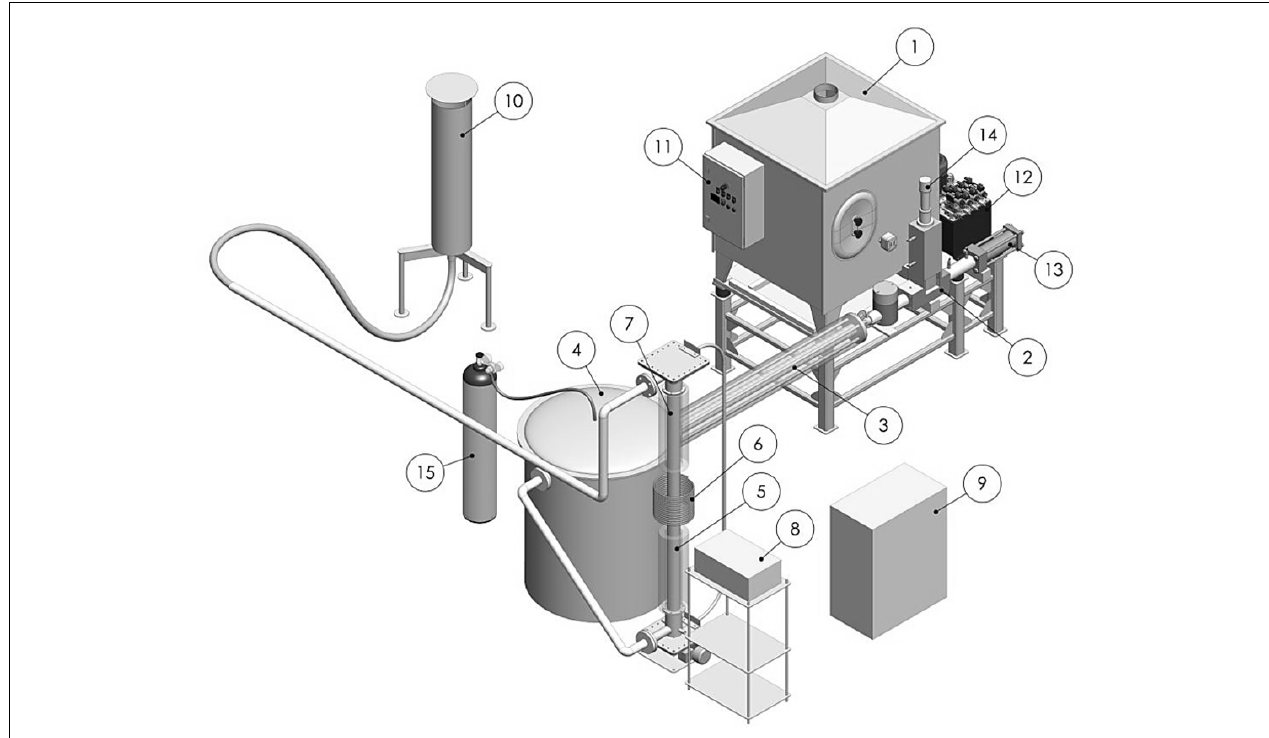
FIGURE 7 | Construction of experimental gasification plant (Bisters et al., 2021): (1) feedstock bunker; (2) hydraulic press feeder; (3) extruder-type pyrolizer; (4) separation chamber – gas and char accumulation tank; (5) secondary gas cracking; (6) external inductive heater – temperature reformer; (7) gas cooler; (8) inductive heater resonator; (9) inductive heater power box; (10) flare; (11) control cabinet; (12) hydro-station; (13) hydro-cylinder; (14) prior hydro-presser box; (15) nitrogen